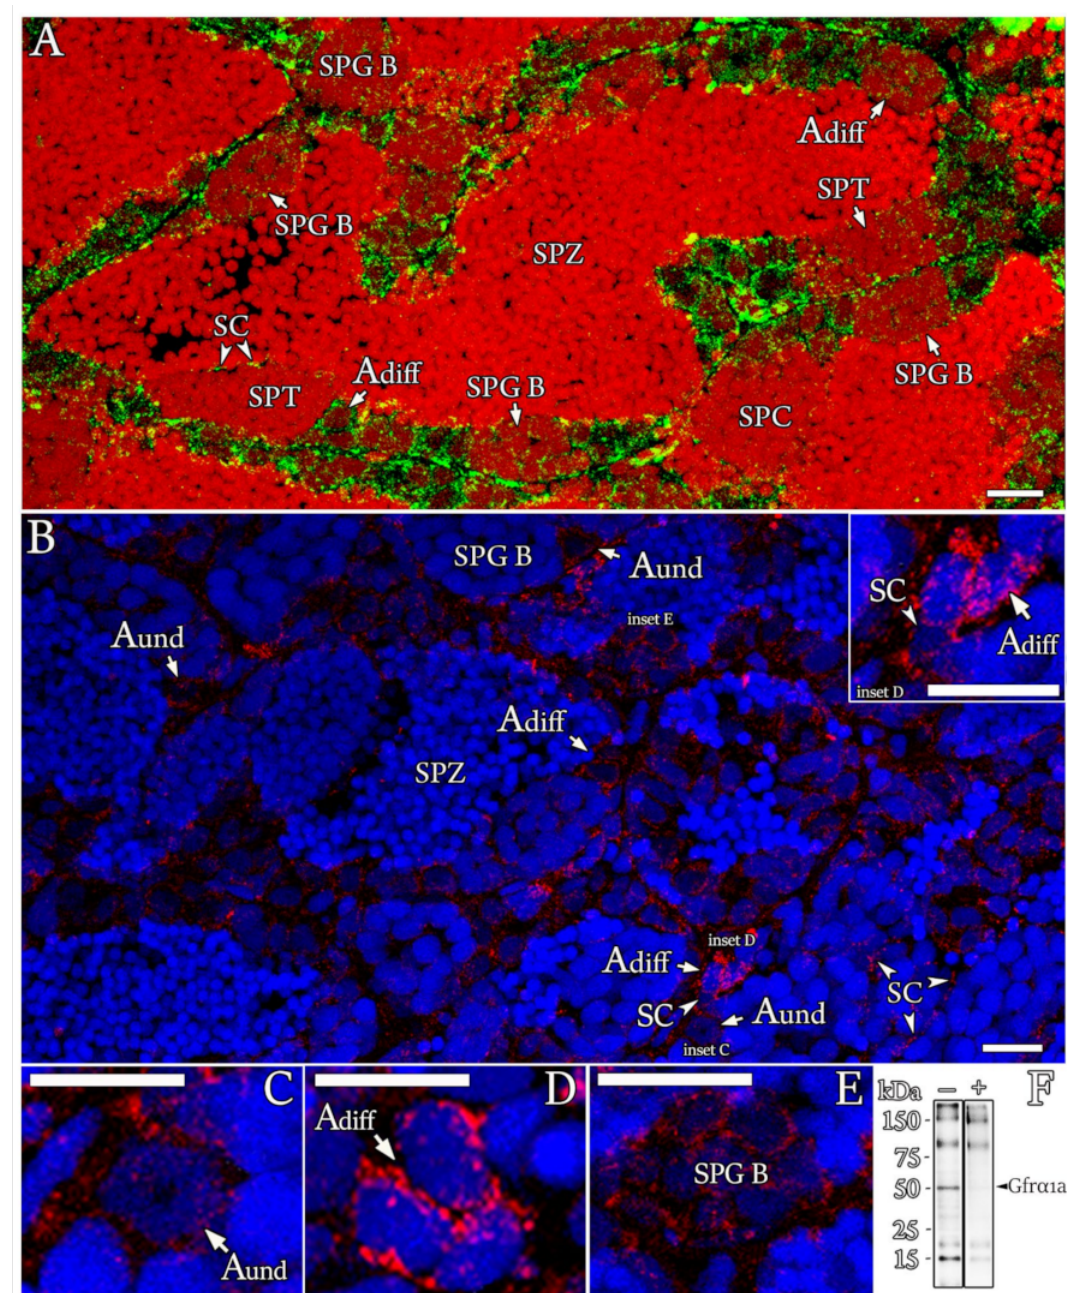
Figure 5. Cellular localization of Gfr α 1a in zebrafish testis. ( A – E ) Immunofluorescence for Gfr α 1a (green— A ; red— B – E ) in testis sections of sexually mature zebrafish. The spermatogonial generations, including type A undifferentiated spermatogonia (A und ), type A differentiated spermatogonia (A diff ) and type B spermatogonia (SPG B), were immunoreactive to Gfra1a, although staining patterns among them varied according to developmental stage. The signal was not found in spermatocytes (SPCs), spermatids (SPTs) and spermatozoa (SPZ). Note that Sertoli cells (SCs) contacting germ cells at different stages of development were also immunoreactive to Gfr α 1a. Cell nuclei were counter- stained with propidium iodide ( A ) or Hoechst ( B – E ). Scale bars: 15 µ m. ( F ) Gfr α 1a (approximately 52 kDa (kilodaltons)) immunoblots of whole testes with (+) or without ( − ) preadsorbed antibodies, confirming the presence of the protein in the zebrafish testes and antibody